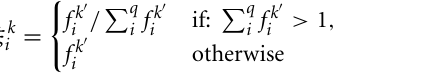
by the number of ORs (centroids). The y-axis shows the normalized number of occurrence pooled over 100 trials, x-axis shows the Euclidean distance d in odorant space. (B) Affinity distribution from which affinities between odorants and receptor pairs are drawn. The y-axis shows the probability to draw an affinity given on the x-axis. The affinity distribution has been obtained by transforming the distance distribution with the given function. (C) Odor input (upper panel) and example membrane potentials (bottom) of an ORN to two different kind of stimuli, odor puff (in blue) and sniffing (black). The blue membrane trace in response to an odor puff is shifted by + 10mV for